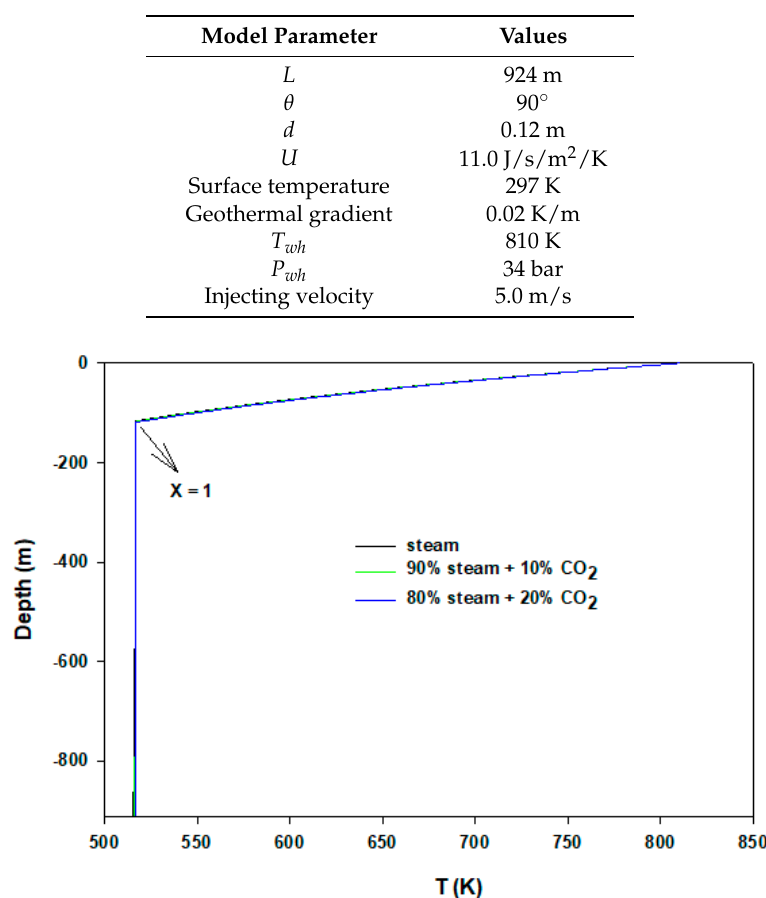
Figure 2. Temperature profiles of steam–CO 2 injections.